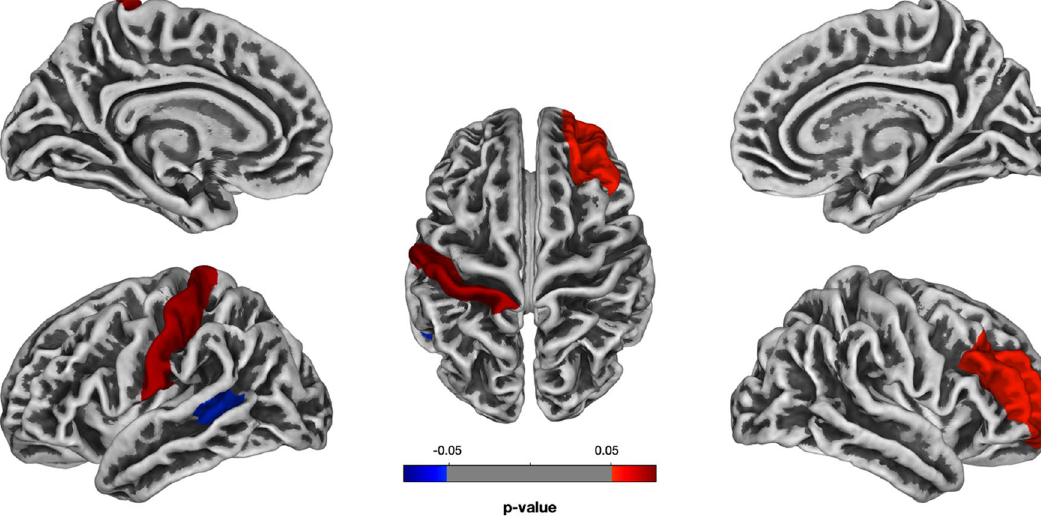
Figure 8. The statistical map for the whole-brain analysis in Fractal Dimension (difference between ASD and TD groups of children, Holm-Bonferroni corrected p < 0.05). Negative p -values refer to the inverse contrasts (ASD >